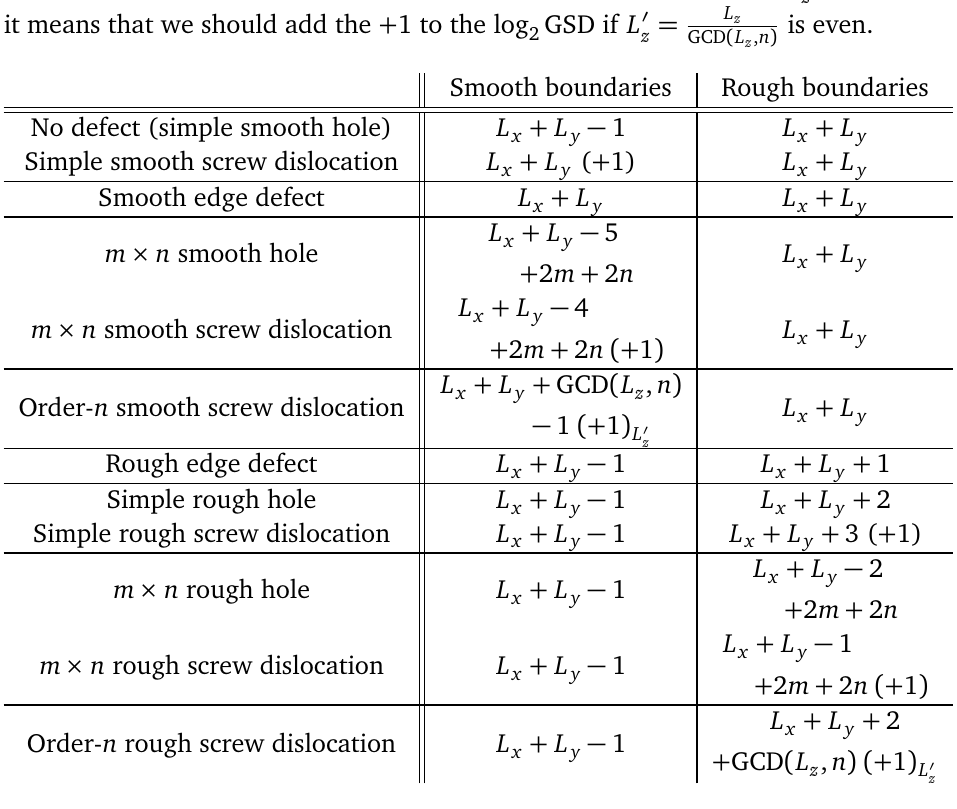
Table 1: log GSD of different geometries. If there is a ‘( + 1)’ suffixed to the result, it 2 means that the given result is for odd L qubit because of the spiralling logical operator. If there is a subscript L (cid:48) it means that we should add the + 1 to the log